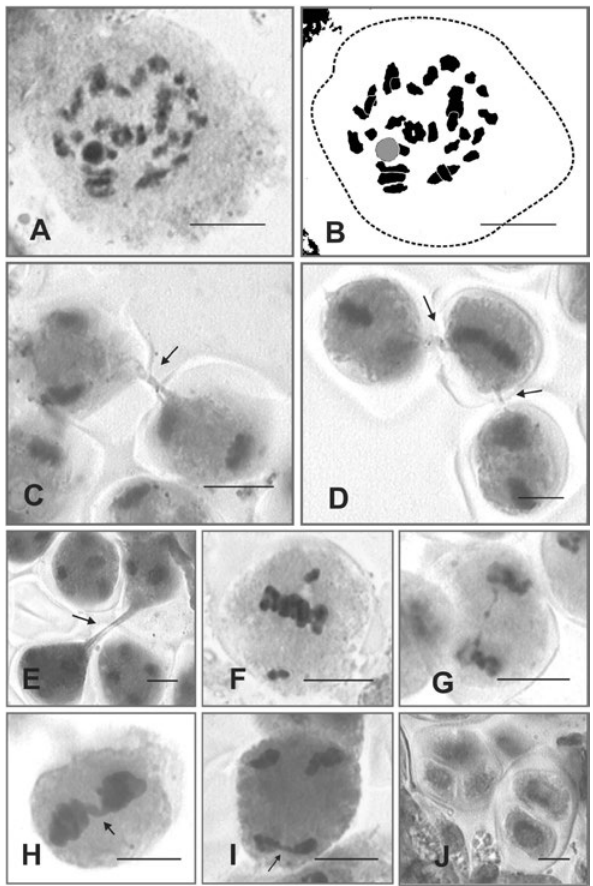
Figure 2. Meiosis in Buddleja iresinoides . A) Diakinesis with n = 28, B) Graphic representation of figure A; C) cytomictic channel in TI connecting 2 cells; D) MII with cytomictic channels connecting 3 cells; E) Cytomixis between tetrads; F) MI with two chromosomes away from the equatorial plate; G) TI showing anaphase bridges with lagging chromatin; H) MII with chromatin stickiness between two equatorial plates; I) AII with chromatin stickiness connecting 2 neighbour poles; J) Dyad and triad. Scale = 10 μm.